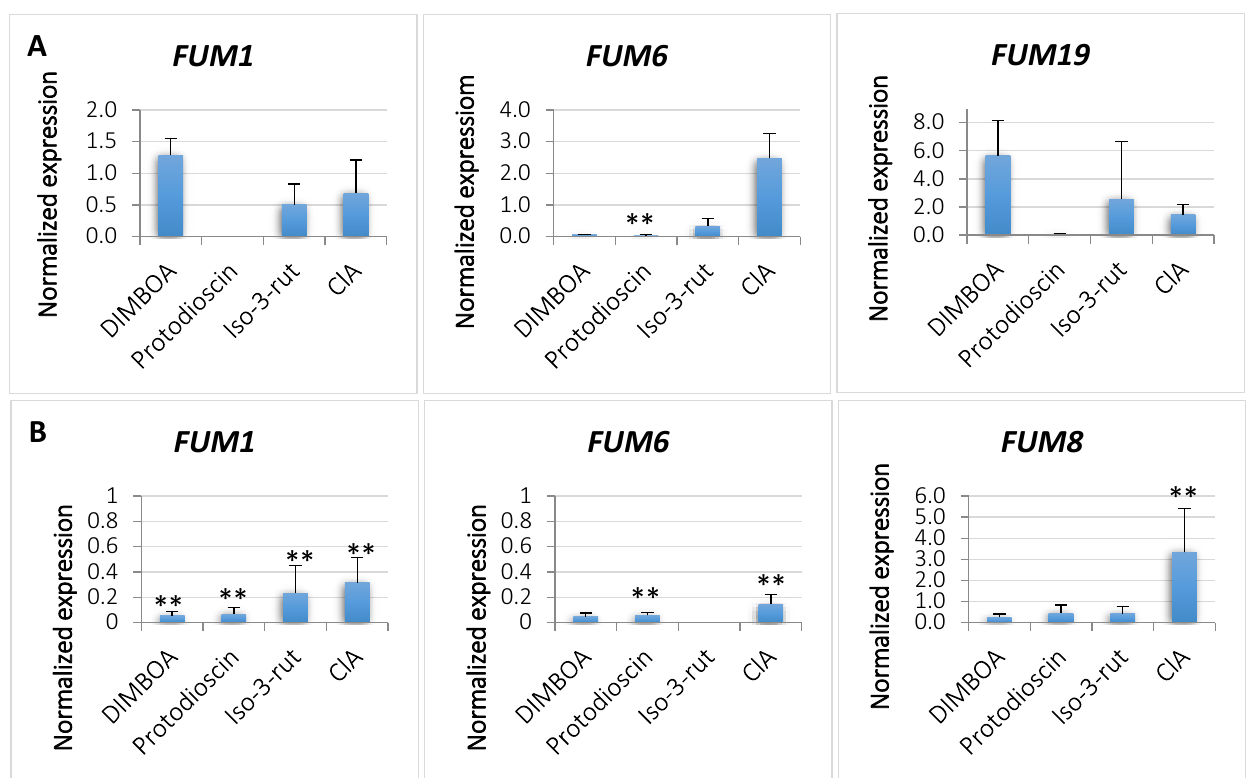
Figure 4. Changes in expression of expression of four FUM genes induced by the plant metabolites in liquid Fusarium proliferatum KF 3360 cultures after 3 ( A ) and 5 days ( B ) after metabolite addition when compared to the control cultures. Average values of three replicates are shown. Differences statistically significant at ** p < 0.01, and standard deviations are shown.